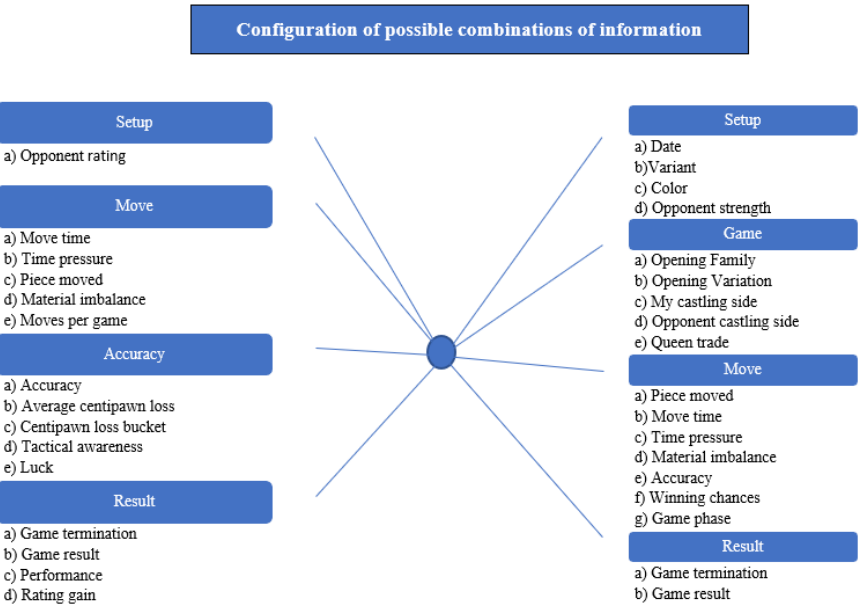
Figure 6. Overview of possible combinations of data from completed chess games. Source: own study.